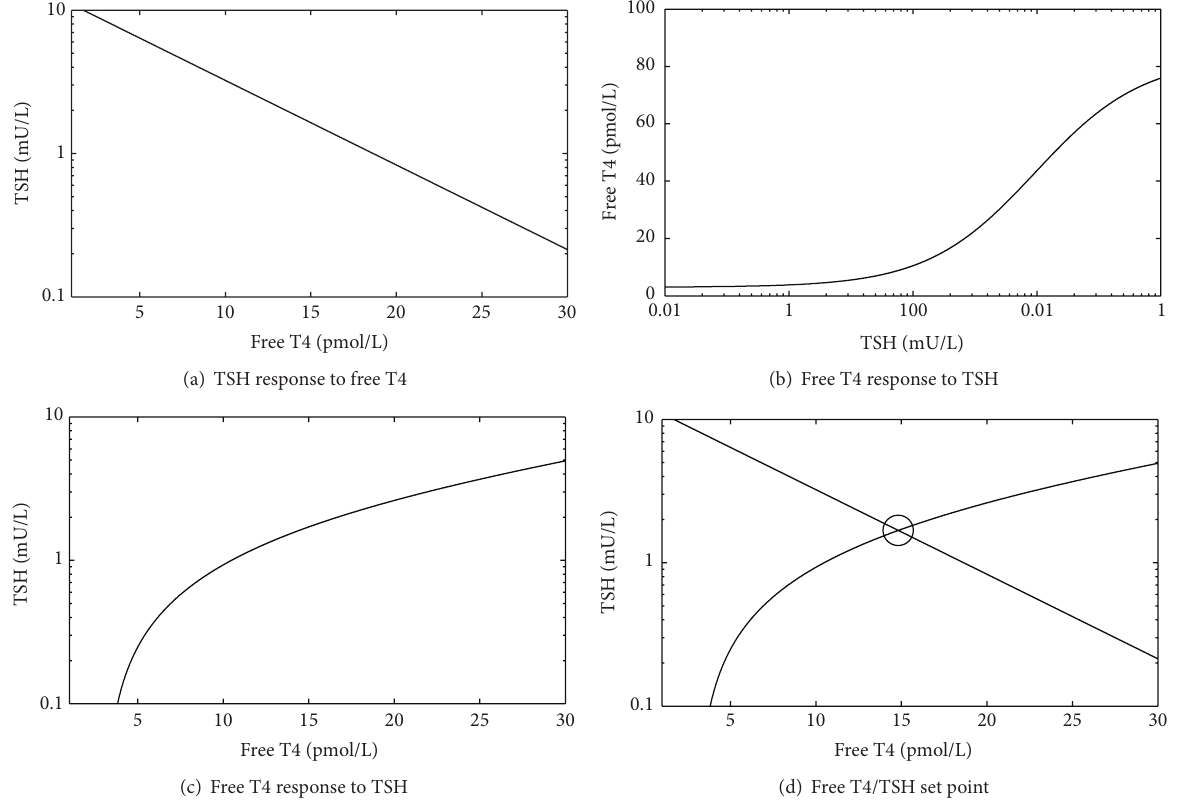
Figure 2: (a) The TSH curve, (b, c) the T4 curve (on different axes, 𝐾 T approx. 41), and (d) the location of the T4/TSH set point.